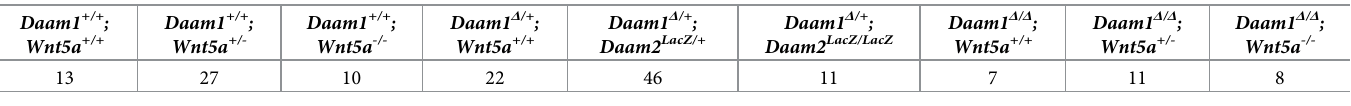
Table 4. Number of Daam1 and Wnt5a mutants at E9.5 stage.